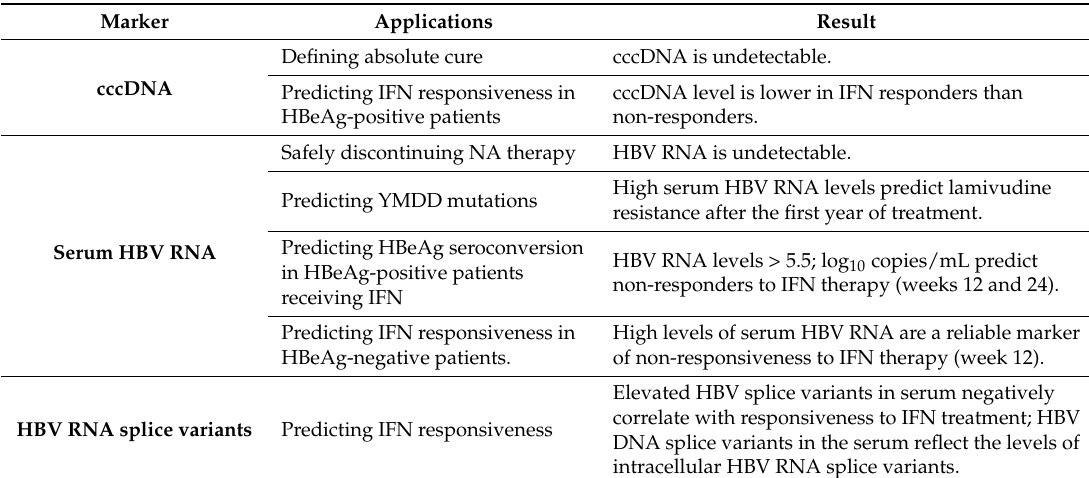
Table 2. Clinical utility of HBV cccDNA and RNAs.